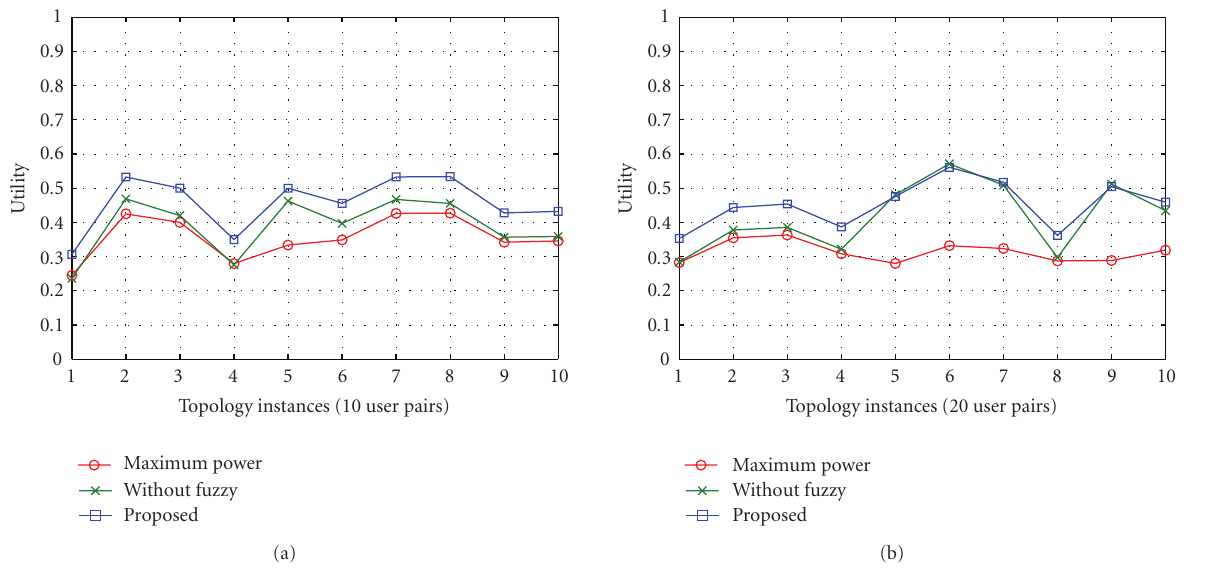
Figure 6: Utility values for the proposed algorithm, the always transmit with the maximum valid power scenario and the original algorithm without coe ffi cient α for (a) 10 and (b) 20 user